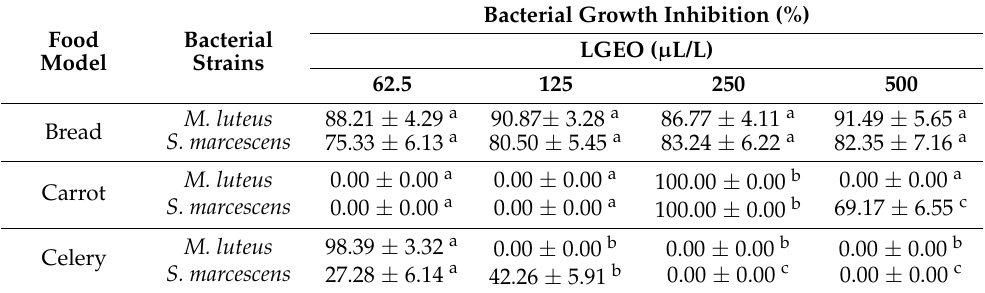
Figure 4. Dendrogram of S. enteritidis generated using the MSPs of the planktonic cells and the control. SE: S. enteritidis; C: control; G: glass; W: wood and P: planktonic. Table 4. Antimicrobial in situ activity of lemongrass essential oil against two bacterial strains growing on selected food